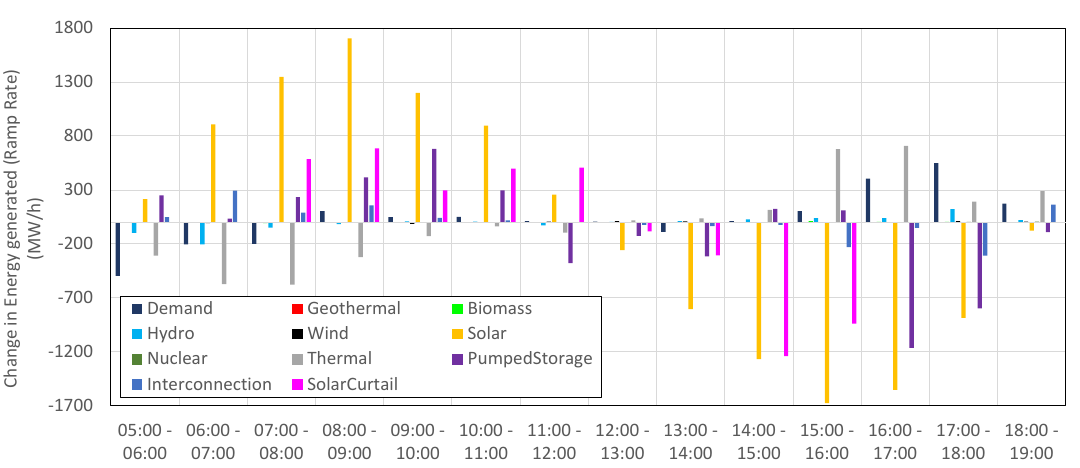
Figure 6. Ramp rate for each supply type on the highest curtailment day, 7 April 2019, 05:00–19:00.